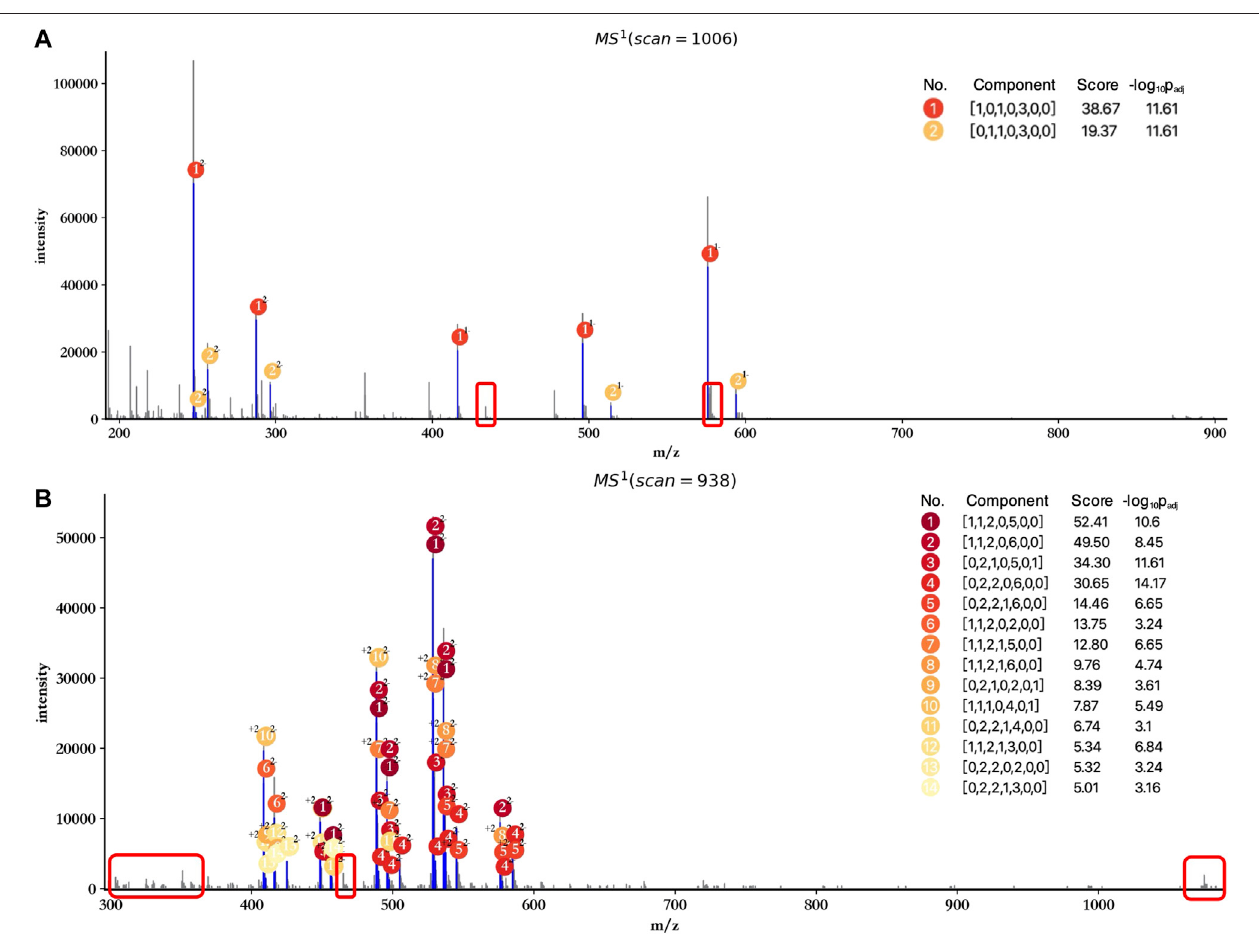
FIGURE 5 | Pro fi ling results of dp2 (A) and dp4 (B) oligosaccharides without peak merging and peak calibration. The regions marked by red rectangles contain isotopic peak clusters with low intensity which can be interpreted in Figure 3 .